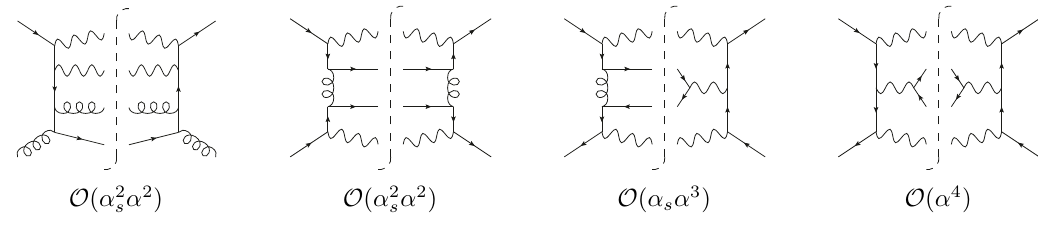
Figure 1 . Illustrative leading and sub-leading tree-level diagrams for (cid:13)(cid:13) + jj production.